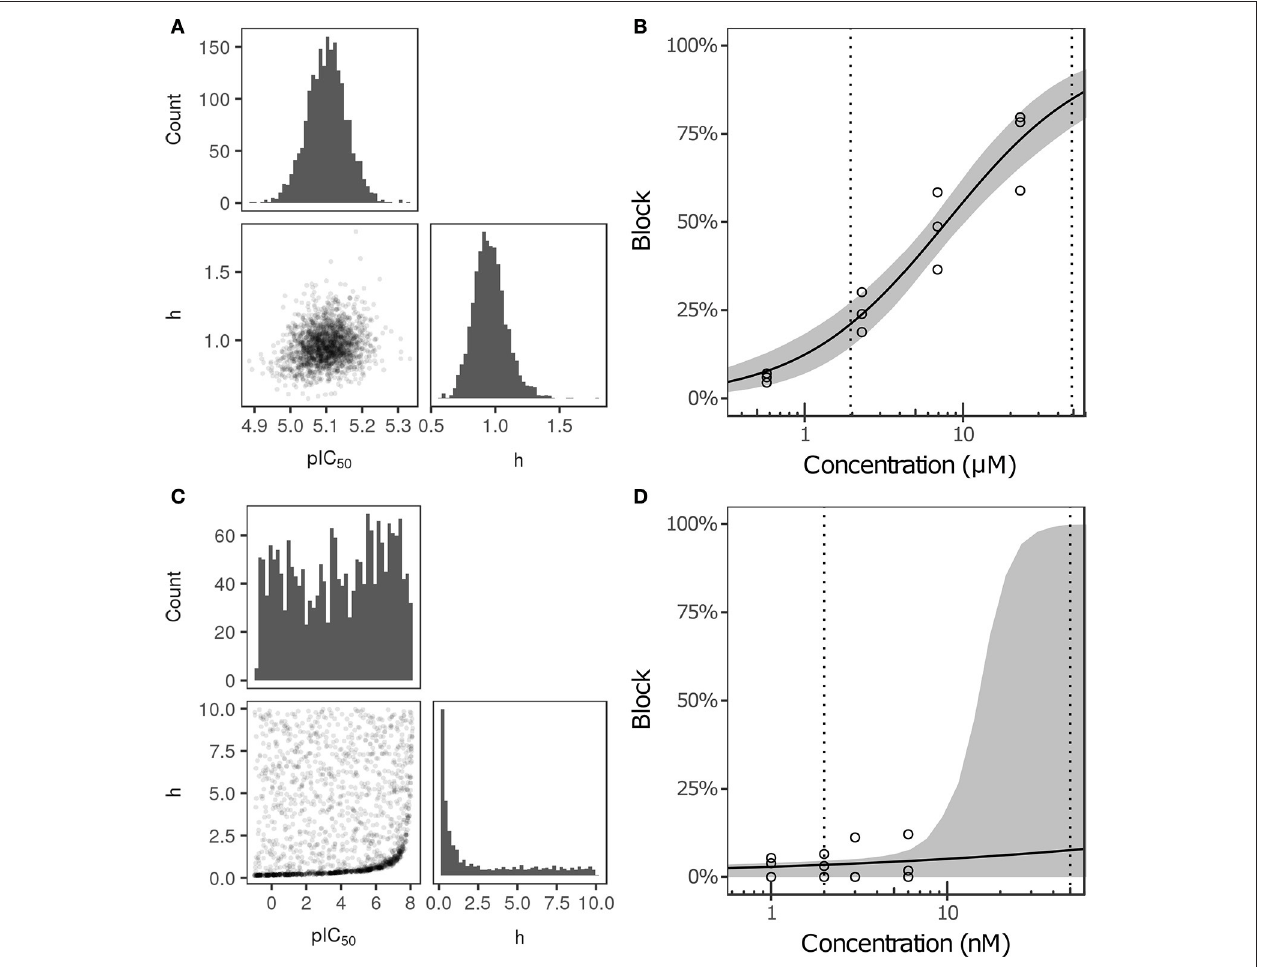
FIGURE 3 | Uncertainty in the dose-response relationship of late sodium current (I NaL ) block by ranolazine (A,B) and dofetilide (C,D) . (A,C) show the joint distribution of pIC 50 and Hill coefficient (h)-values, estimated with a Bayesian inference approach. Marginal histograms are displayed on the diagonal plots, and pairwise scatter plots are below the diagonal (2,000 samples per drug). IC 50 -values are in nM. (B,D) show the dose-response relationships for the two drugs. Solid lines show the Hill equation defined by IC 50 - and h-values from Li et al. (2017). Shaded areas denote the 95% CI of the percentage block at each concentration, as determined by the parameters in (A,C) . Circles are the experimental values used to fit the dose-response curves. Vertical dotted lines indicate the limits of the concentration range used in AP simulations (1 − 25 × C max